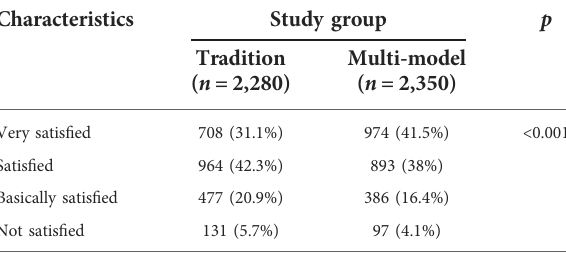
TABLE 5 Comparison of patients ’ satisfaction between traditional process group and multimodal practice group.